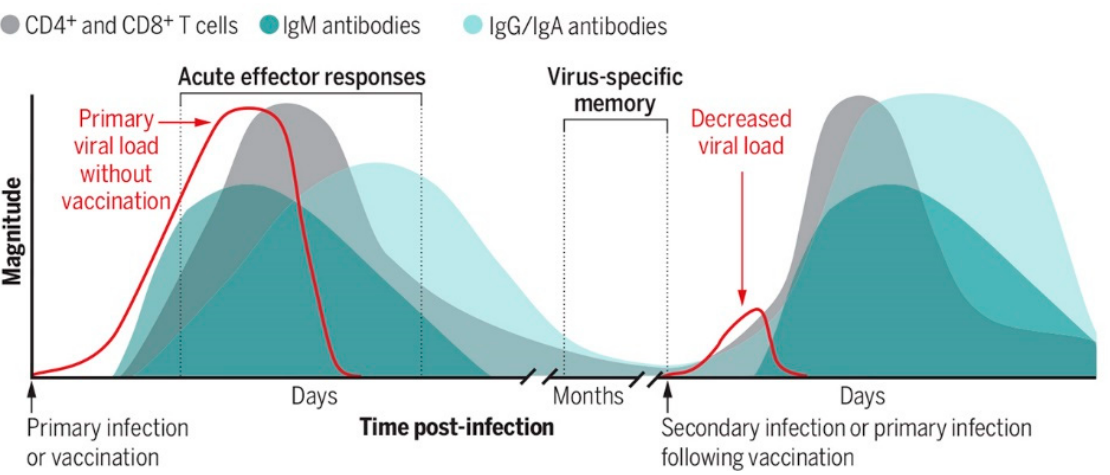
Figure 5. Viral invasion triggers the adaptive immune